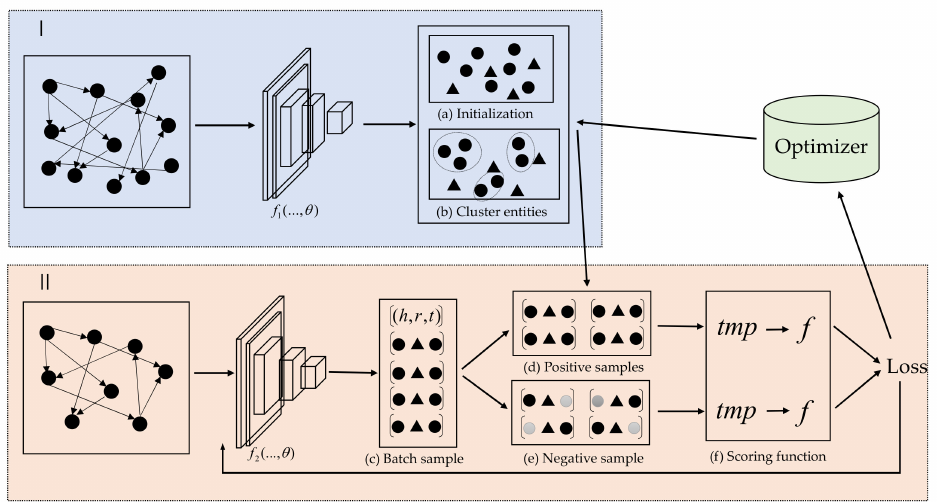
Figure 4. The Op‑Trans method framework. Part ( I ) of the figure is the initialization module. The backbone maps the entities and relations in the knowledge graph into a low‑dimensional dense vec‑ tor space, as shown in ( a ), where the circles in the figure represent the entities in the knowledge graph and the triangles represent the relations in the knowledge graph. We cluster the entities according to their mapping features, as shown in ( b ). Part ( II ) of the figure represents the training phase, and ( c ) represents the triplet ( h , r , t ) sample batches extracted from training. the triplets in the sample batch are treated as positive triplets, as shown in ( d ). A corresponding negative triplet is generated for each positive triplet participating in the training, as shown in ( e ). The scoring function is calcu‑ lated for each triplet in ( f ), where tmp is the computed mapping properties for each triplet and is the computed score for each